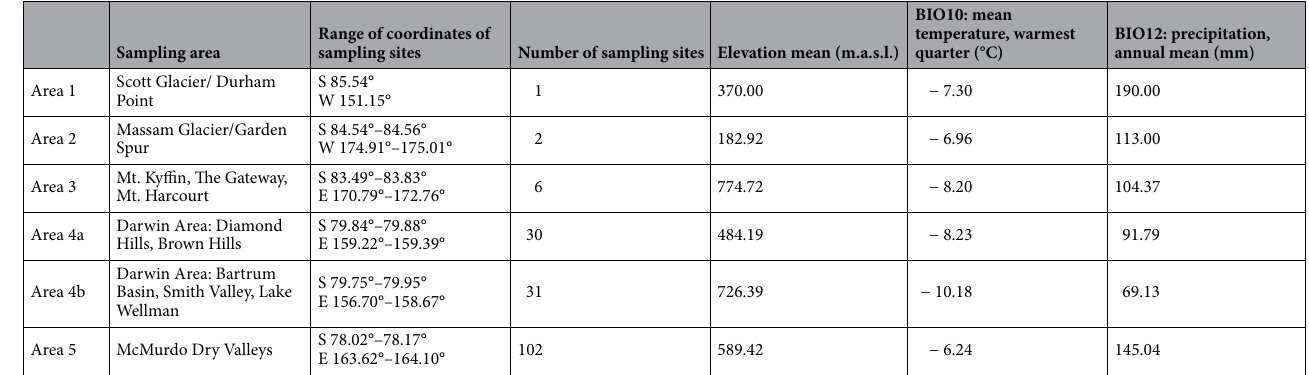
Table 1. Site descriptions of the six regions defined in the present study, including range of the coordinates of the sampling sites and areas, the number of sampling sites and the BIOCLIM variables BIO10 (mean temp. of the warmest quarter) and BIO12 (annual precipitation) per